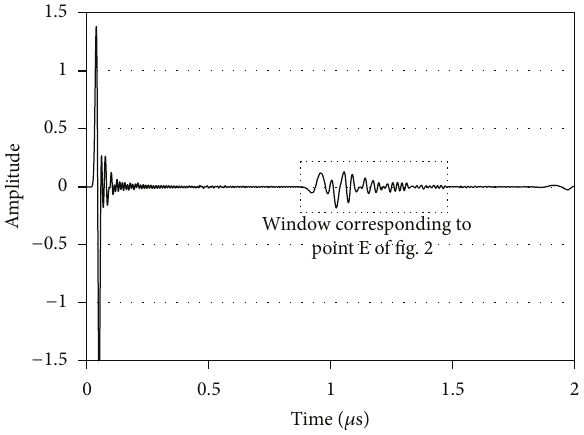
Figure 4: Typical waveform after excitation of 25